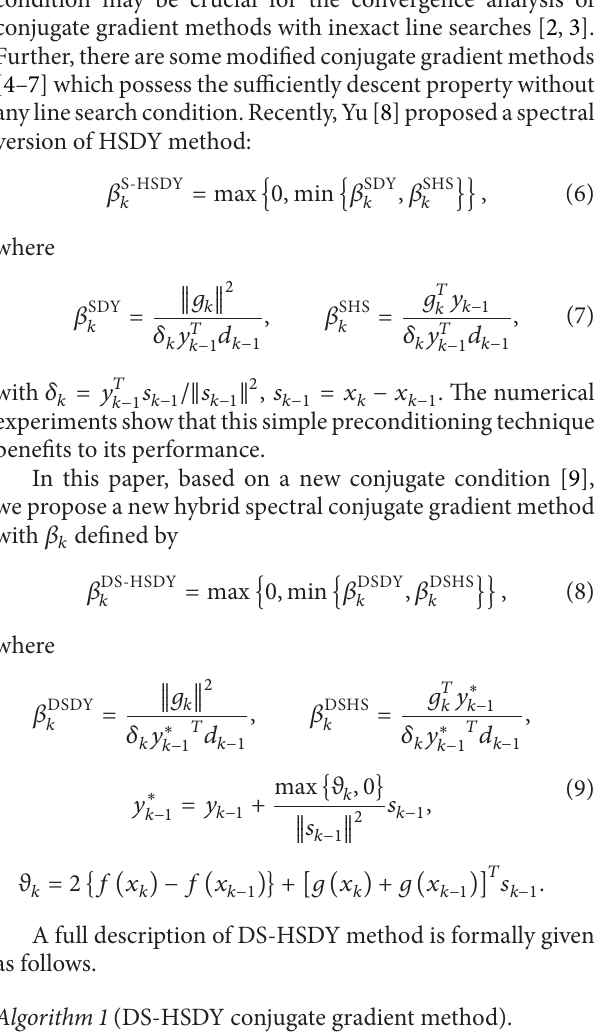
Algorithm 1 (DS-HSDY conjugate gradient